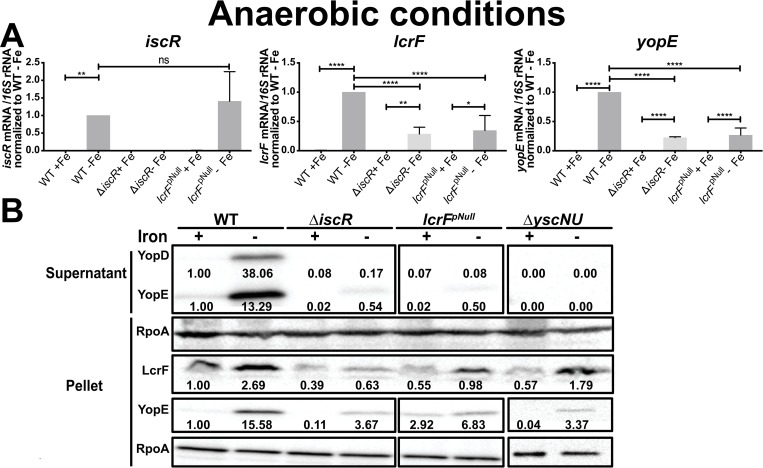
Iron limitation induces iscR, lcrF, and yopE expression and type III secretion under fermentative conditions.Iron-limited Y. pseudotuberculosis was shifted to iron-replete (+Fe) or iron-limited (-Fe) M9/high glucose media in the absence of oxygen and type III secretion induced at 37°C for 4 hrs. (A) RNA was isolated and qPCR used to determine relative expression of iscR, lcrF, and yopE by normalizing to 16S rRNA levels. Data shown represent the average of four independent experiments. *p ≤ 0.05, **p ≤ 0.005, ****p≤0.0001****p≤0.0001, as determined by one-Way ANOVA with Tukey post-test. (B) T3SS cargo proteins secreted into culture supernatant and precipitated with TCA were probed with antibodies for YopE and YopD. Cell lysates were probed with antibodies for RpoA, YopE, and LcrF. All samples shown are from the same experiment, with each lysate split into two gels, one subsequently used for LcrF probing and the other for YopE probing. RpoA was used as a loading control. One representative experiment out of four is shown. Densitometric quantification of the bands was performed using Image Lab software (Bio-Rad), setting the WT (+Fe) band to 1.00.